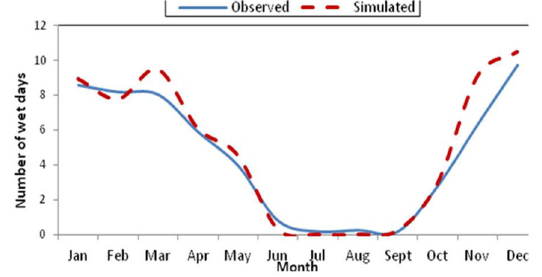
Figure 5. Averagemonthlywetdaysoftheobserved&thesimulated during calibration and validation periods (1961-2001).